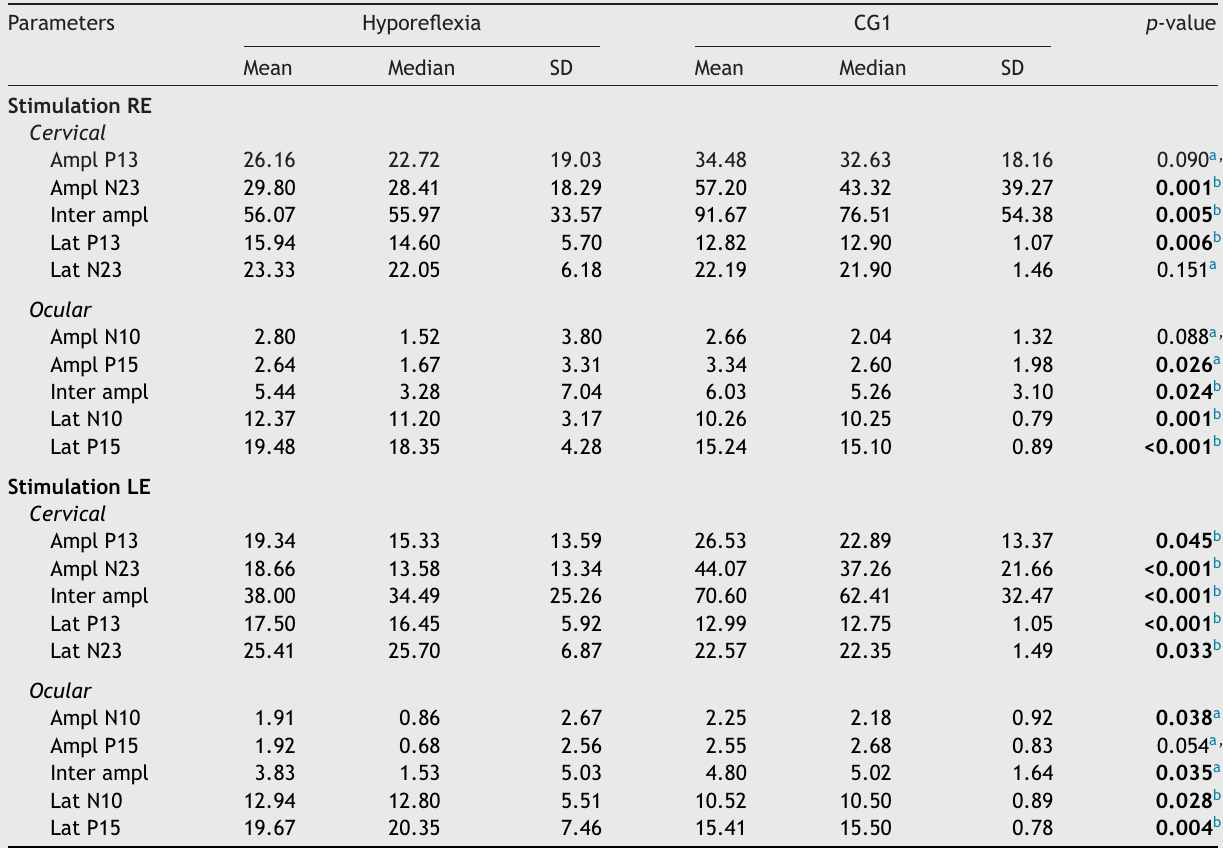
Table 3 Comparison of individuals with vestibular hyporeflexia and the control group (CG1) for latency (ms) and amplitude ( (cid:2) V) for combined cervical and ocular VEMP.